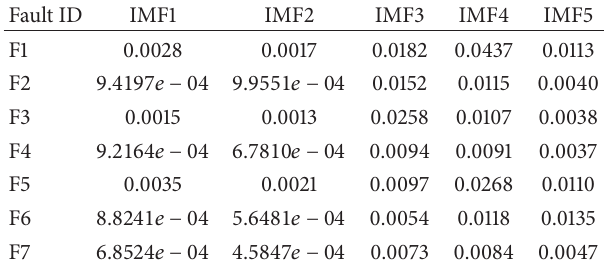
Table 4: Scale parameter 𝛾 values of IMFs (c1–c5).